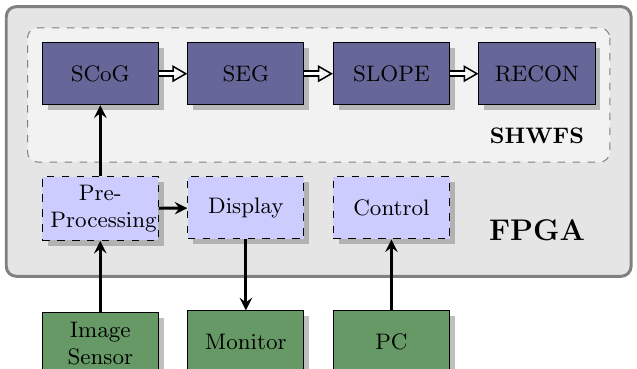
Figure 2. Top level block diagram of the SHWFS implementation where the implementation of the SHWFS is described